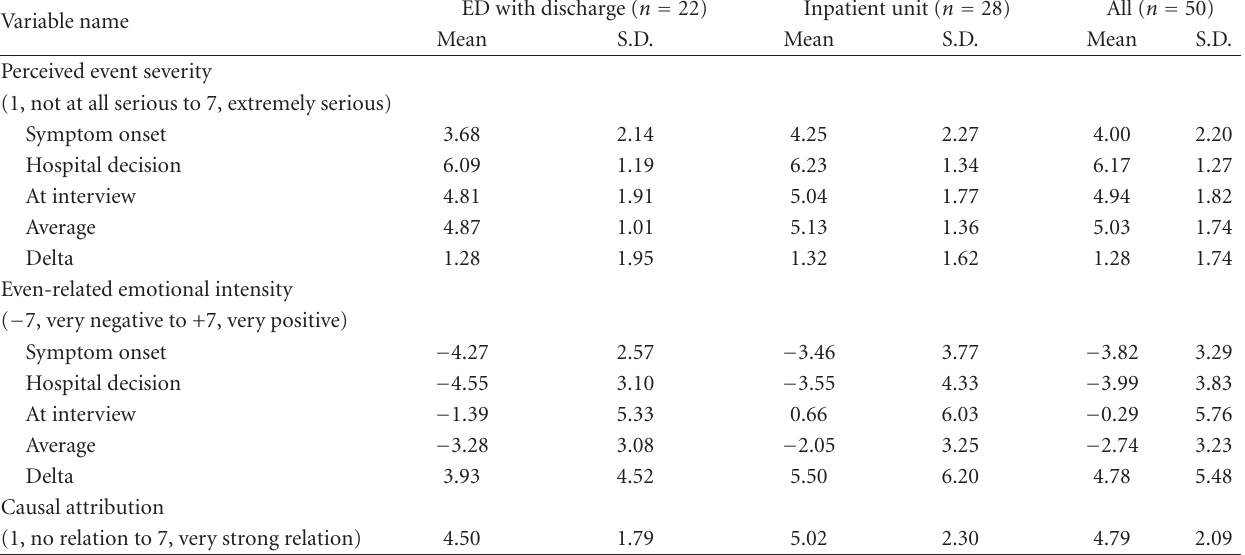
Table 1: Descriptive statistics of constructs.